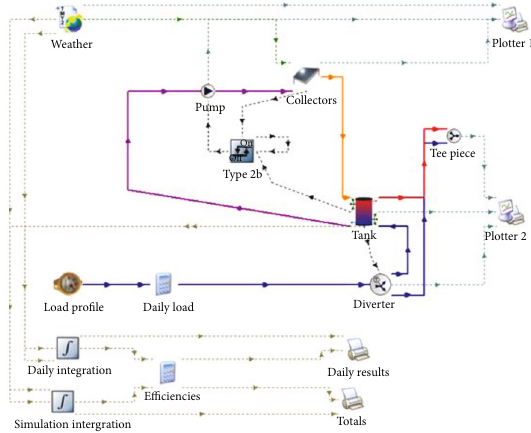
Figure 8: Designed solar water heater system in TRNSYS